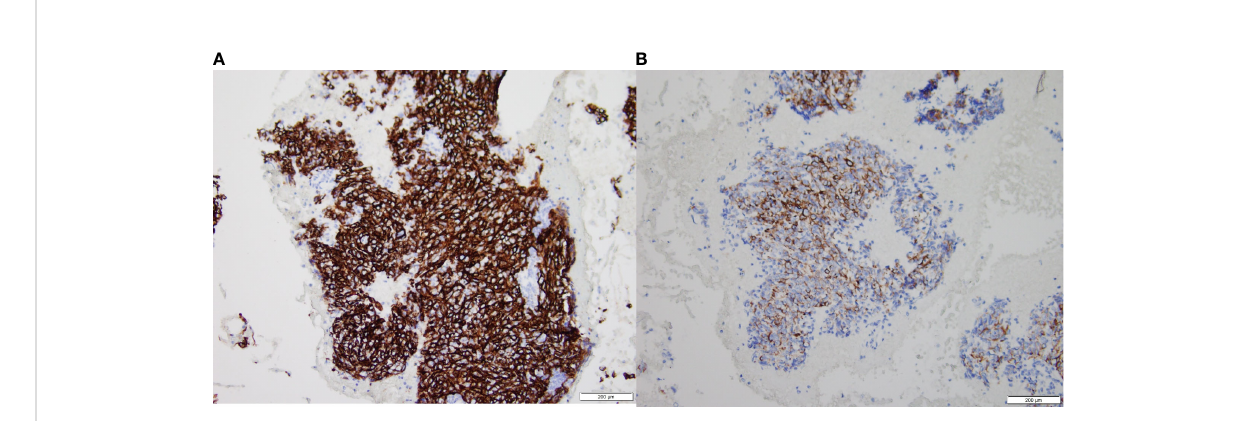
FIGURE 8 ASPH expression in intermediate and advanced cervical cancer tissues, (A) is high expression results. (B) is low expression